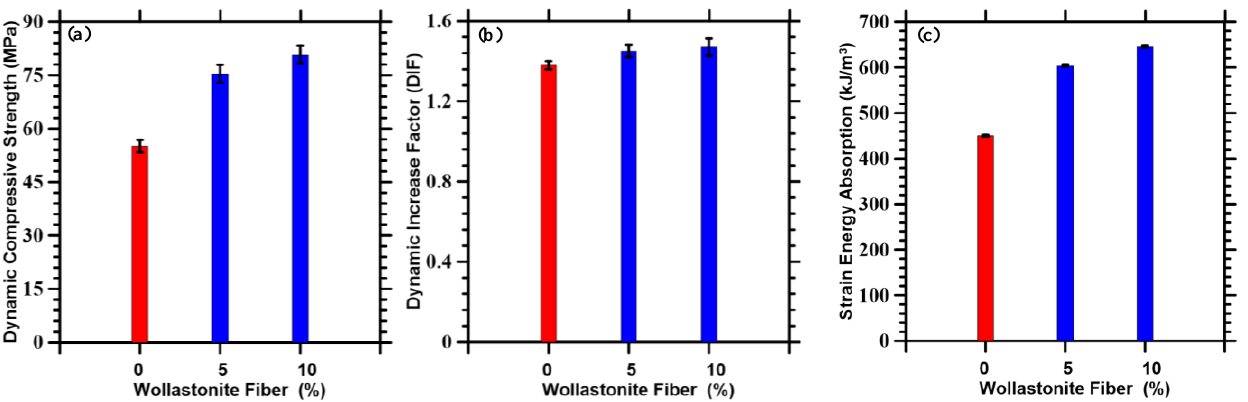
Figure 6. Dynamic properties: ( a ) compressive strength, ( b ) dynamic increase factor, and ( c ) strain energy absorption for varying wollastonite content at a strain rate of 200/s.